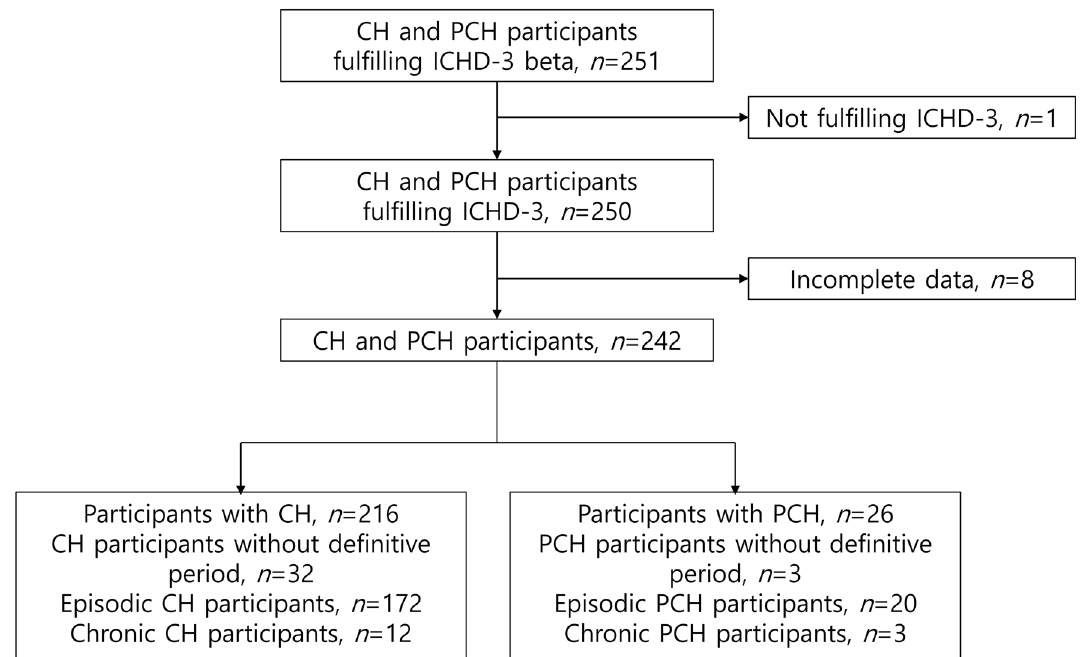
Figure 1. Flow diagram of participant selection. CH cluster headache, ICHD-3 The third edition of the International Classification of Headache Disorders, ICHD-3 beta The third edition beta version of the International Classification of Headache Disorders, PCH probable cluster